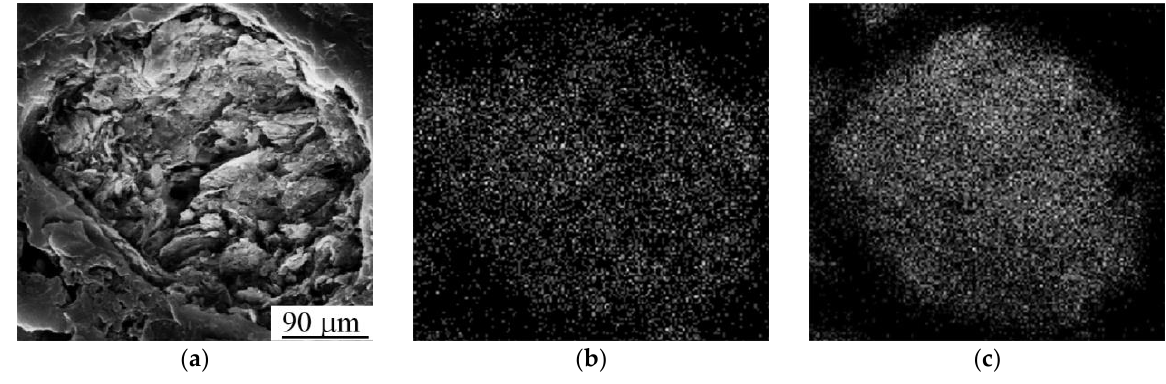
Figure 5. ( a ) SEM image and mapping patterns of ( b ) Ti and ( c ) Nb.